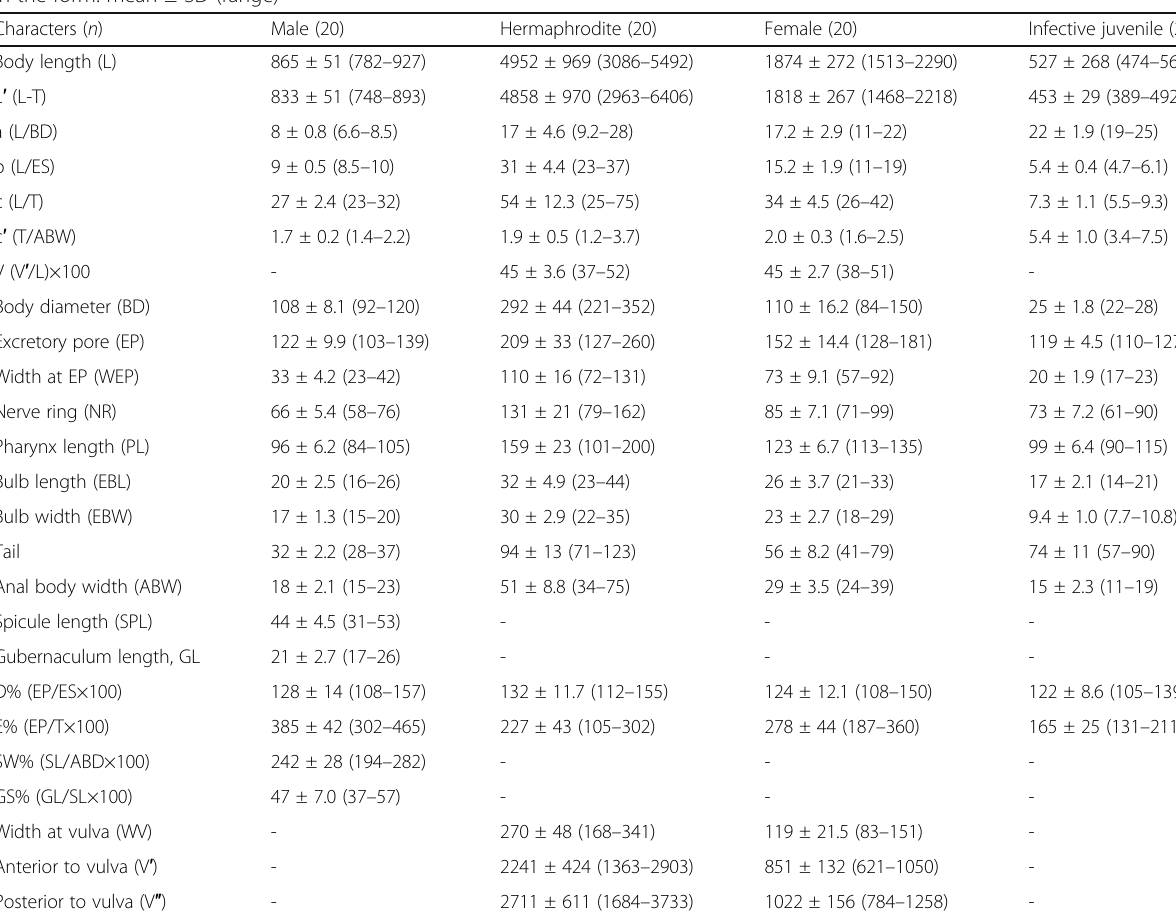
Table 1 Morphometric data for Heterorhabditis bacteriophora PH. All measurements are in μ m (except n , ratio and percentage) and in the form: mean ± SD